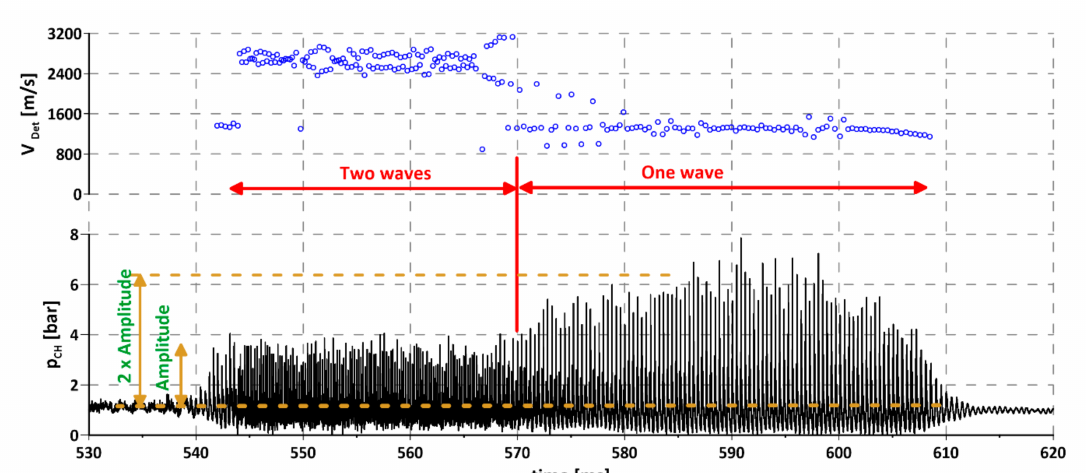
Figure 5. Propagation of rotating detonation for kerosene–air mixture with gaseous addition, di ff erent mode of propagation: One and two